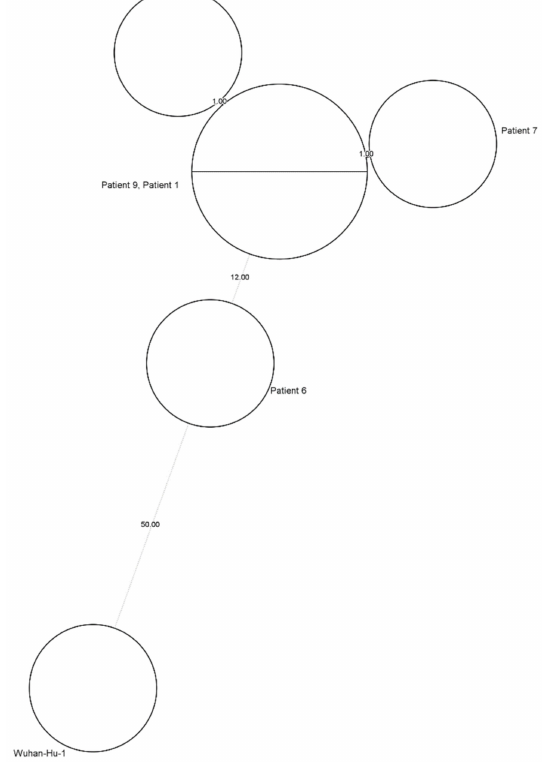
Figure 3. MST analysis of a possible outbreak cluster in 5 patients, with the Wuhan-Hu-1 as reference genome (NC